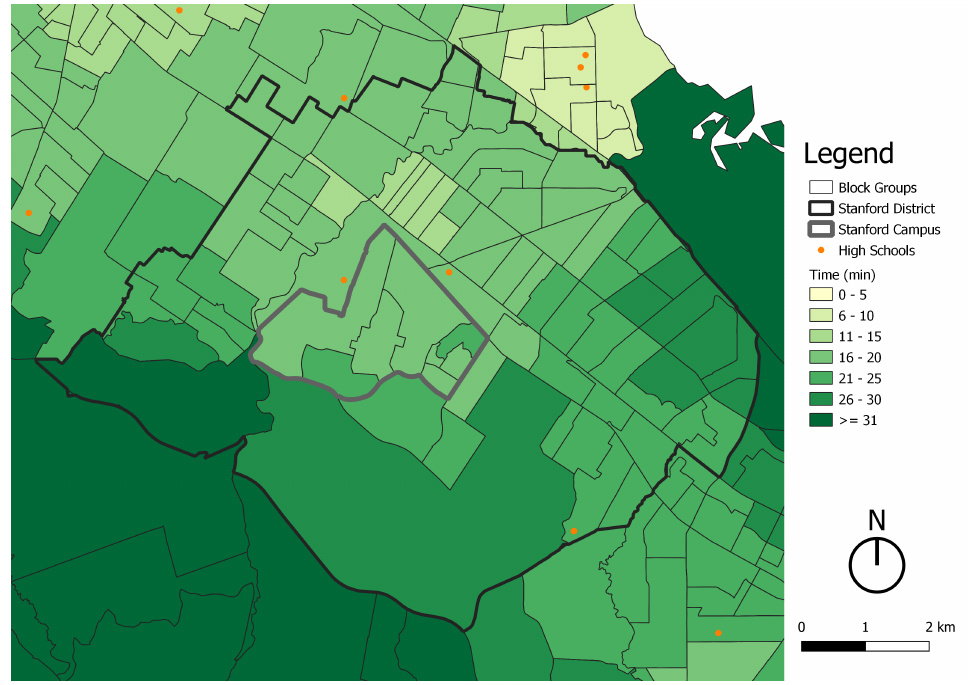
Figure 16. Stanford District average travel time to the 3 closest public high schools by